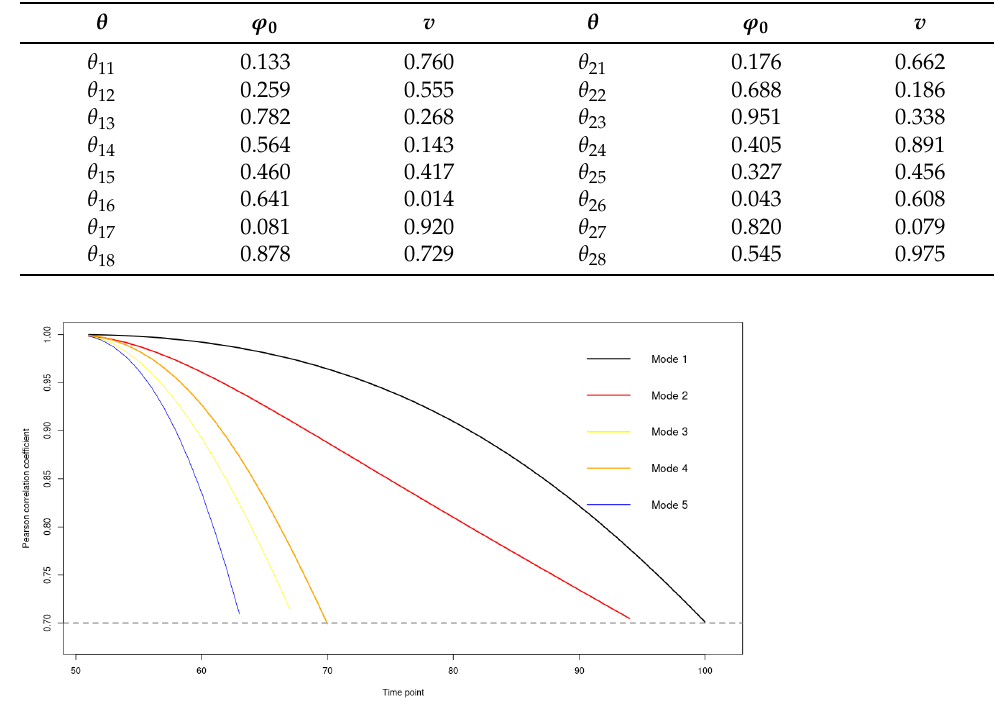
Table 1. The training parameters.